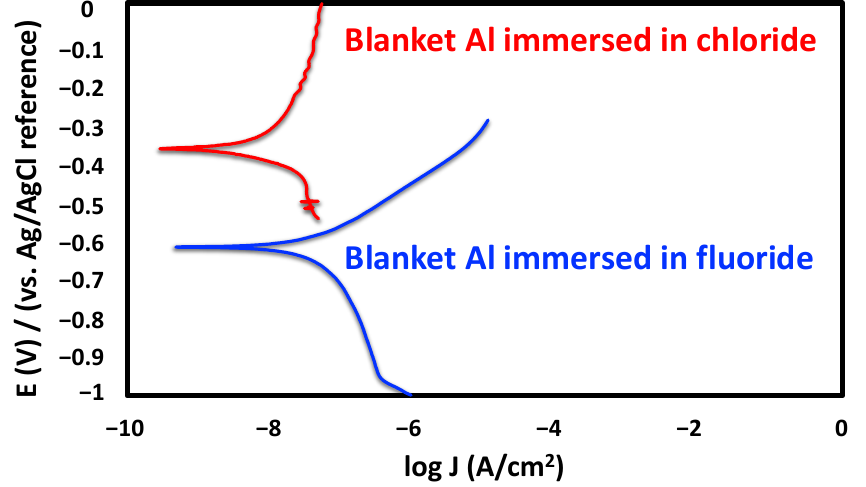
Figure 4. Tafel plot analysis of Al without bimetallic contact in Cl − and F − containing solutions (5 ppm, pH 5). The scan rate used is 0.001 V/s.